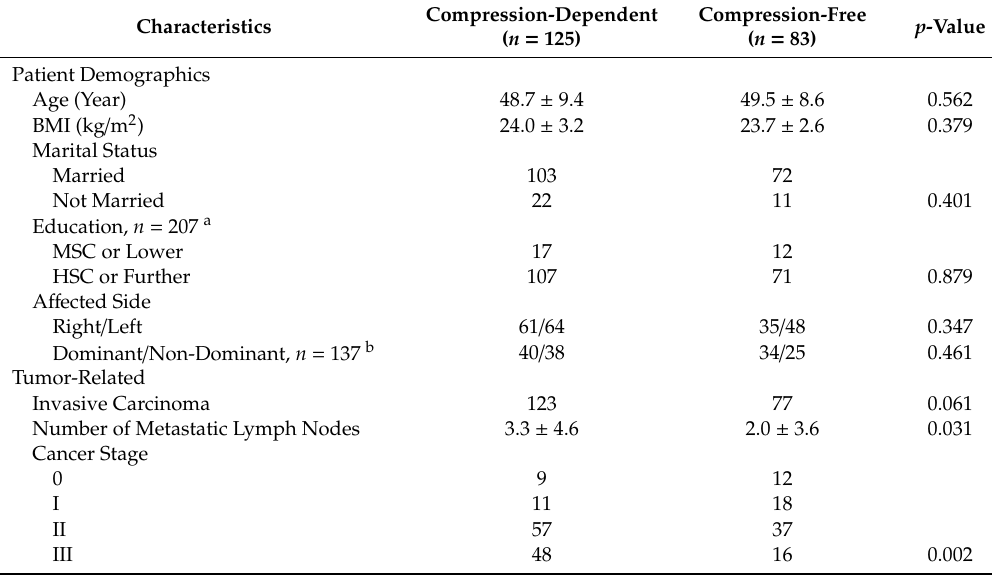
Table 2. Comparison of characteristics between the compression-dependent and compression- free